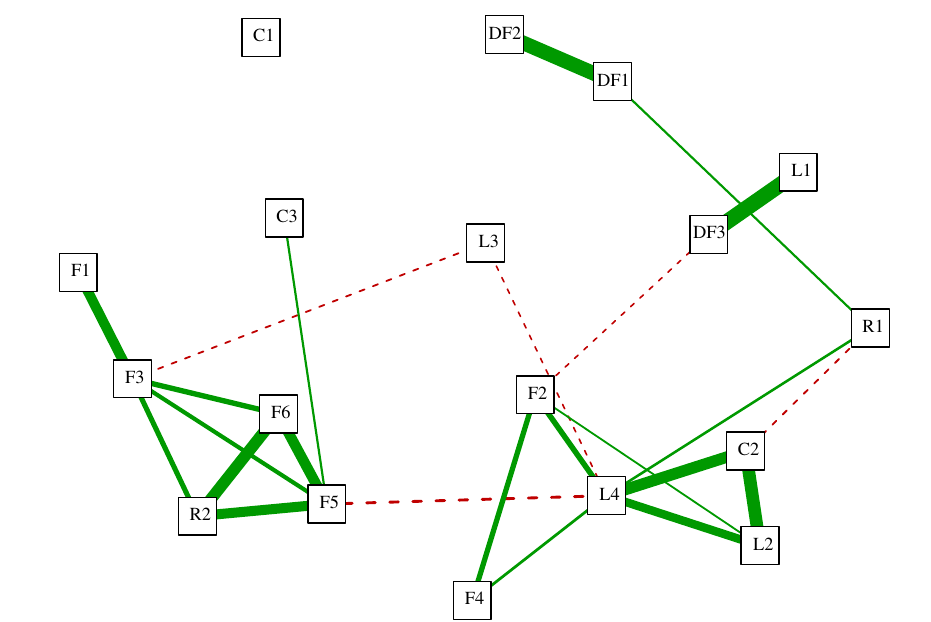
FIG. 4. Correlation matrix of student ability using model 3. Lines represent correlations with j r j > 0 . 15 . Line thickness represents the size of the correlation. Solid (green) lines represent positive correlations; dashed (red) lines negative